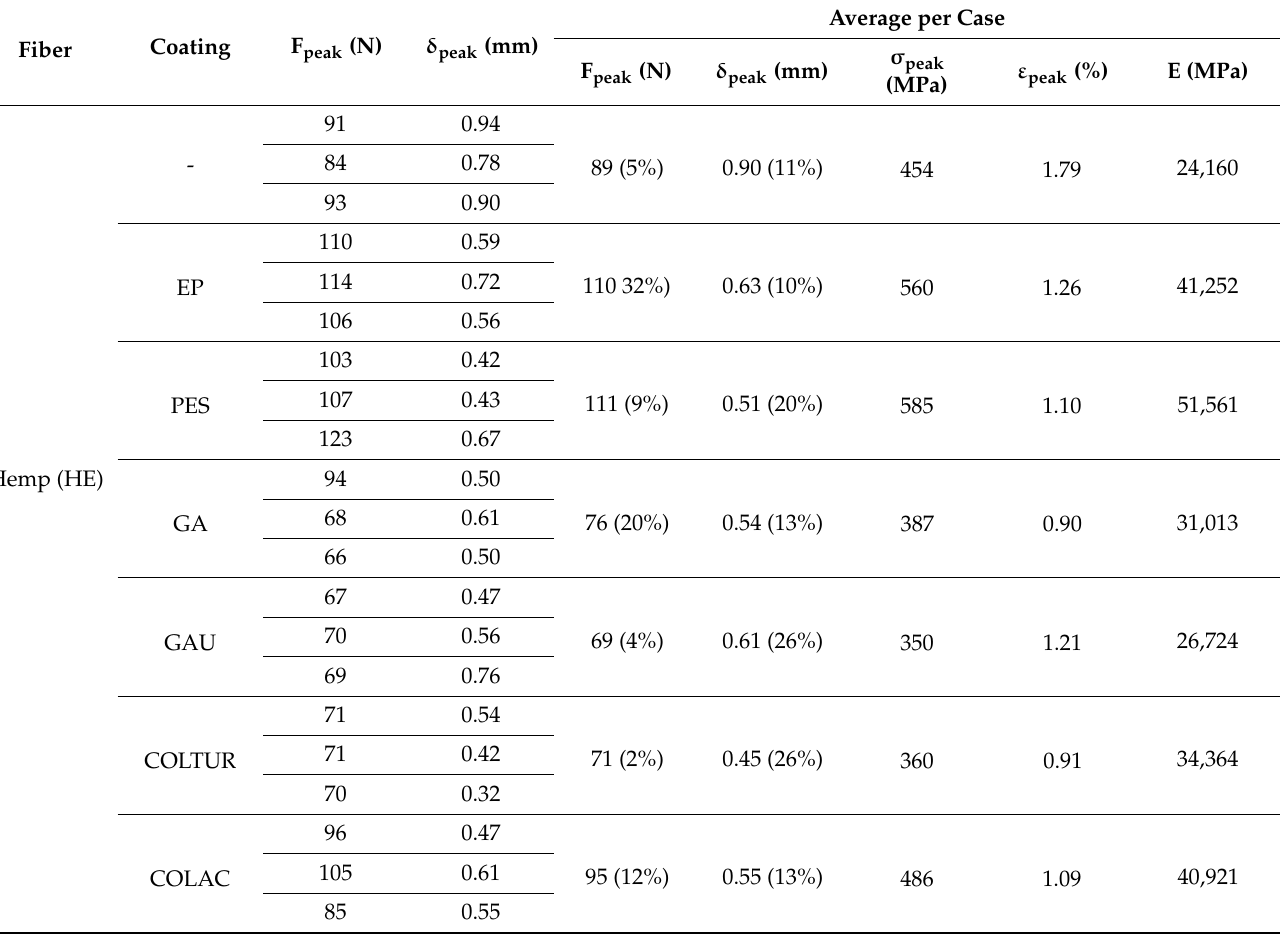
Table 6. Hemp yarns’ tensile test